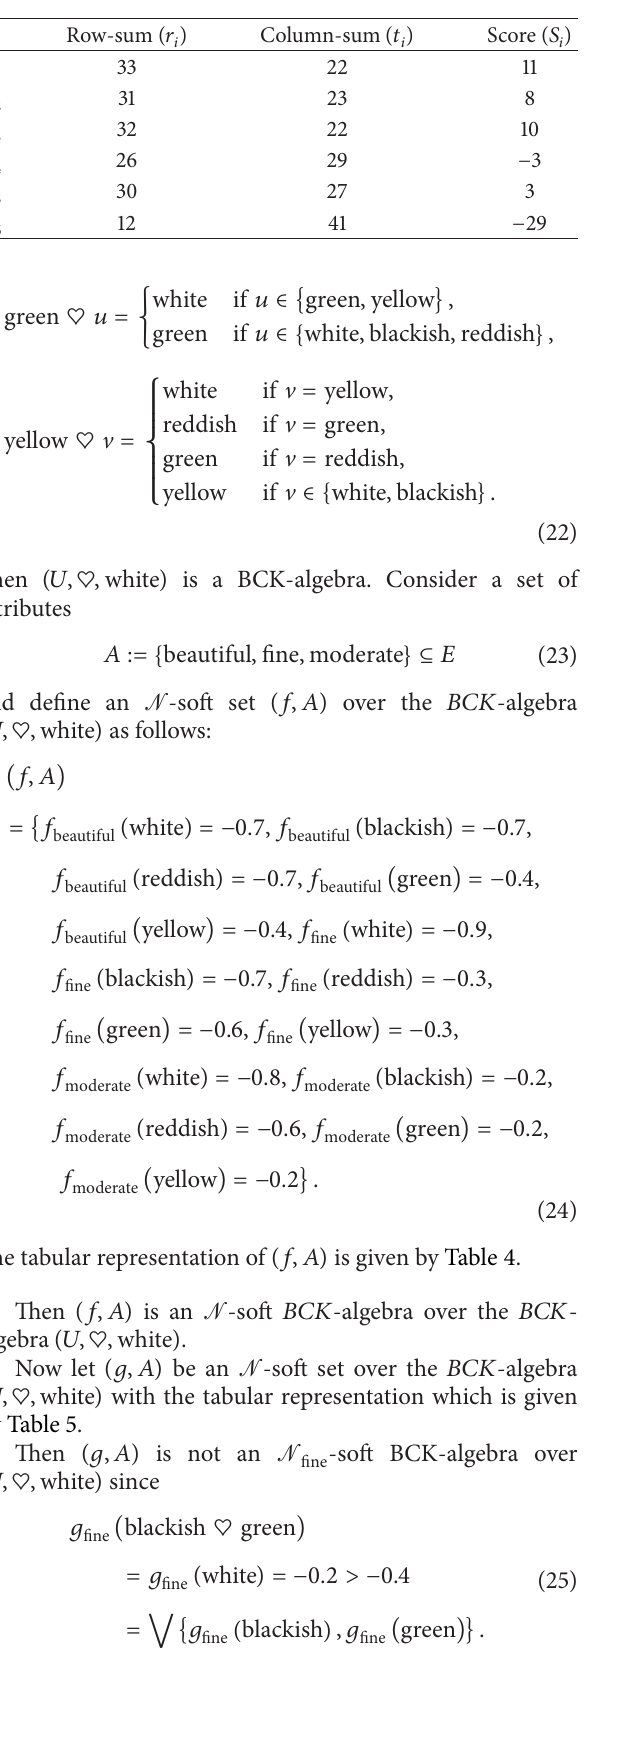
Table 4: Tabular representation of (𝑓, 𝐴)